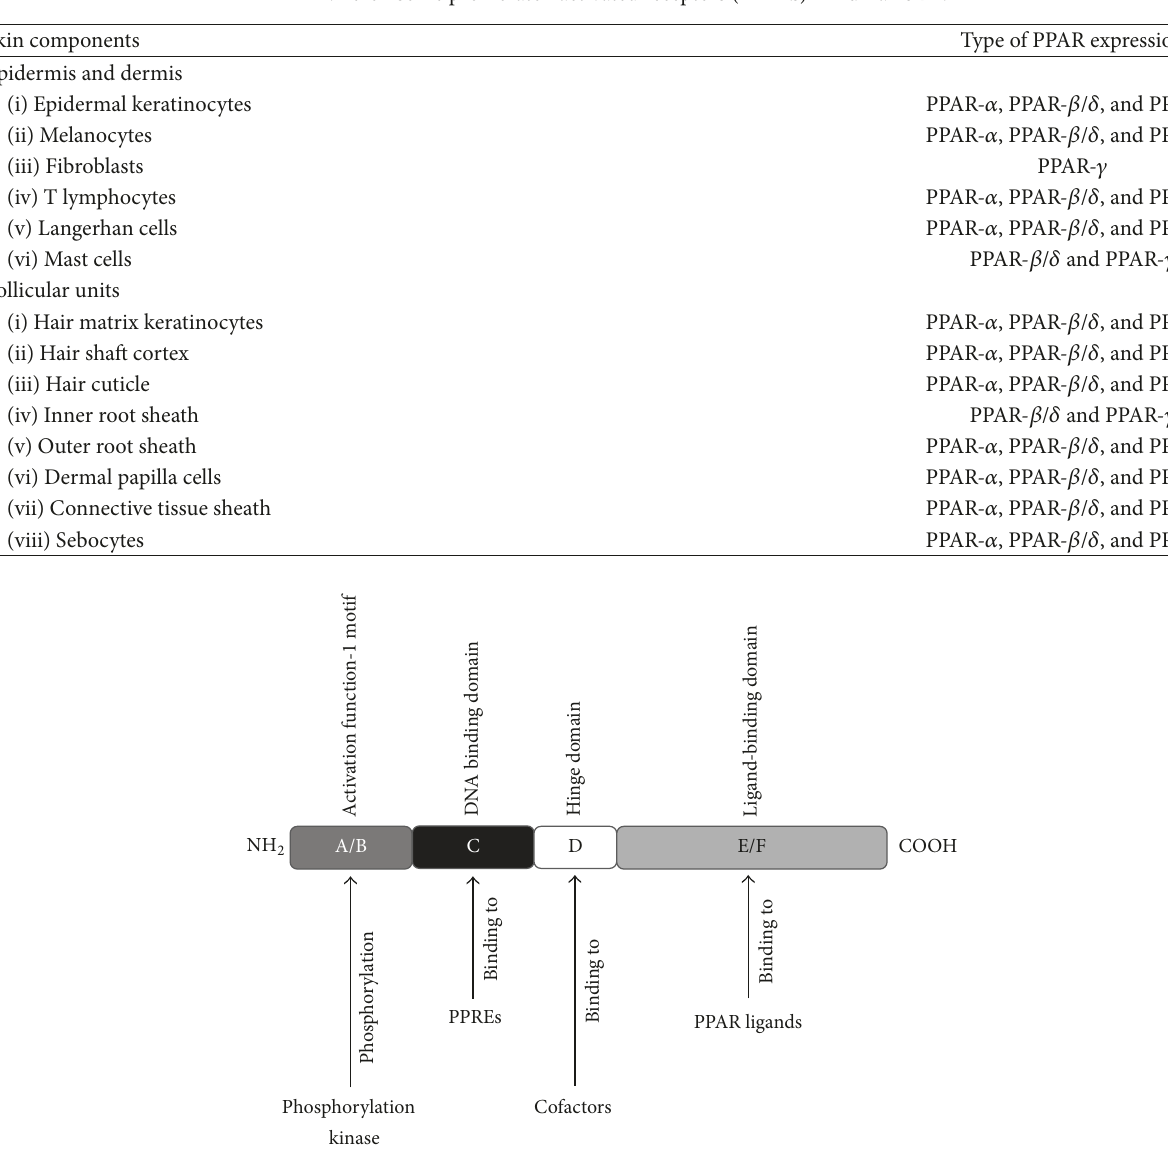
Figure 4: Diagram of the functional domain of